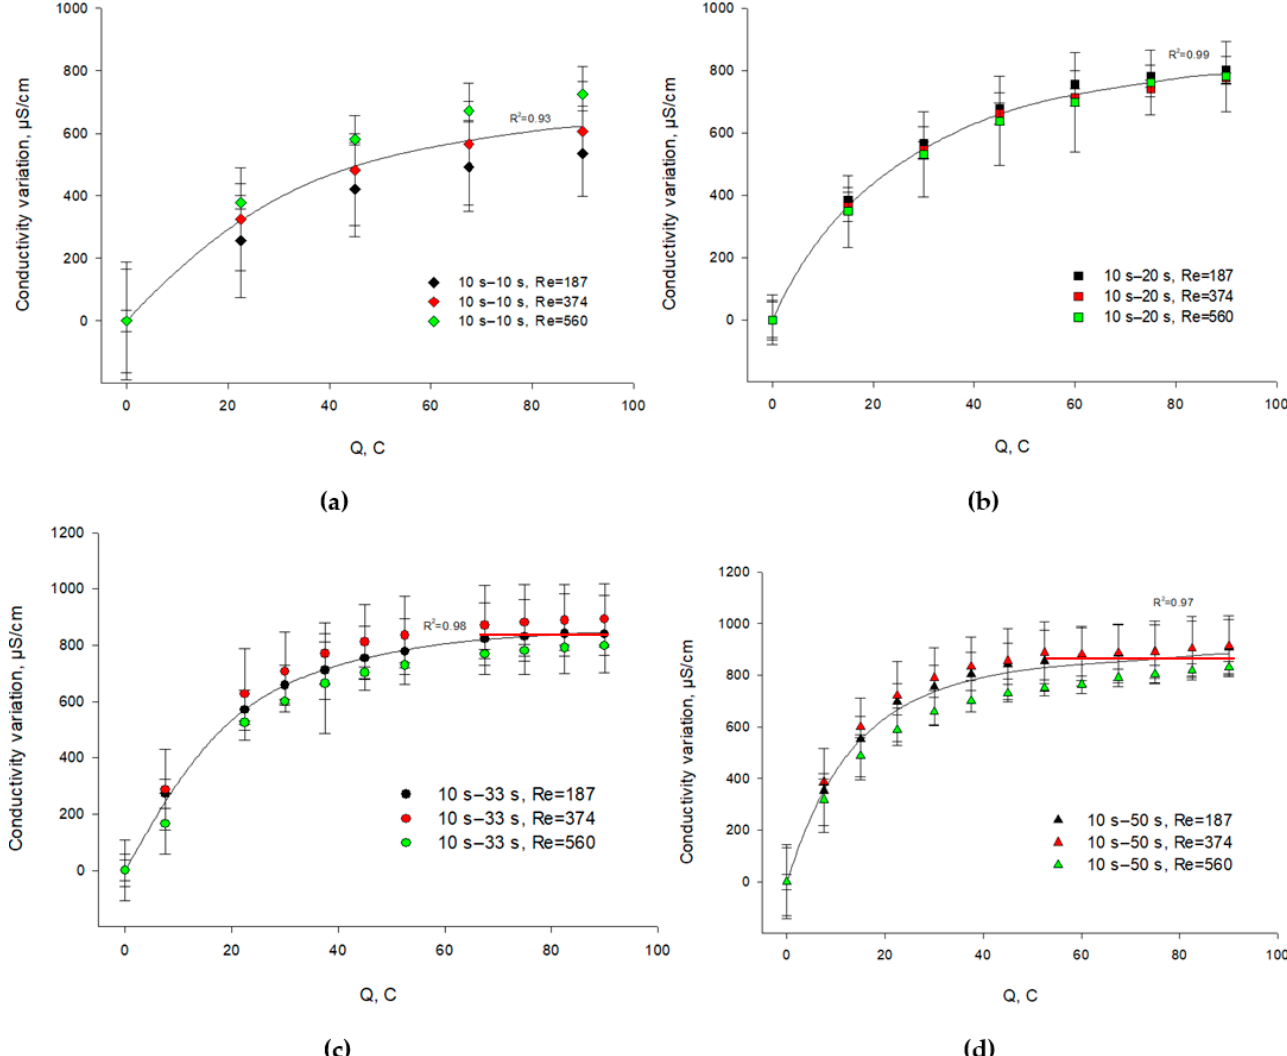
Figure 7. Evolution of caseinate stream conductivity variation as a function of the amount of transferred charges (in C) during EDBM in PEF mode carried out at different flow rates (expressed in Reynolds numbers) and different pause durations; the regimes studied: ( a ) 10 s–10 s, ( b ) 10 s–20 s, ( c ) 10 s–33 s and ( d ) 10 s–50 s. Reynolds numbers of 187, 374 and 560 correspond to linear velocities of 7.8, 15.6 and 23.4 cm/s, respectively. The red lines are added for the visualization of the steady-state plateau of the caseinate solution conductivity.